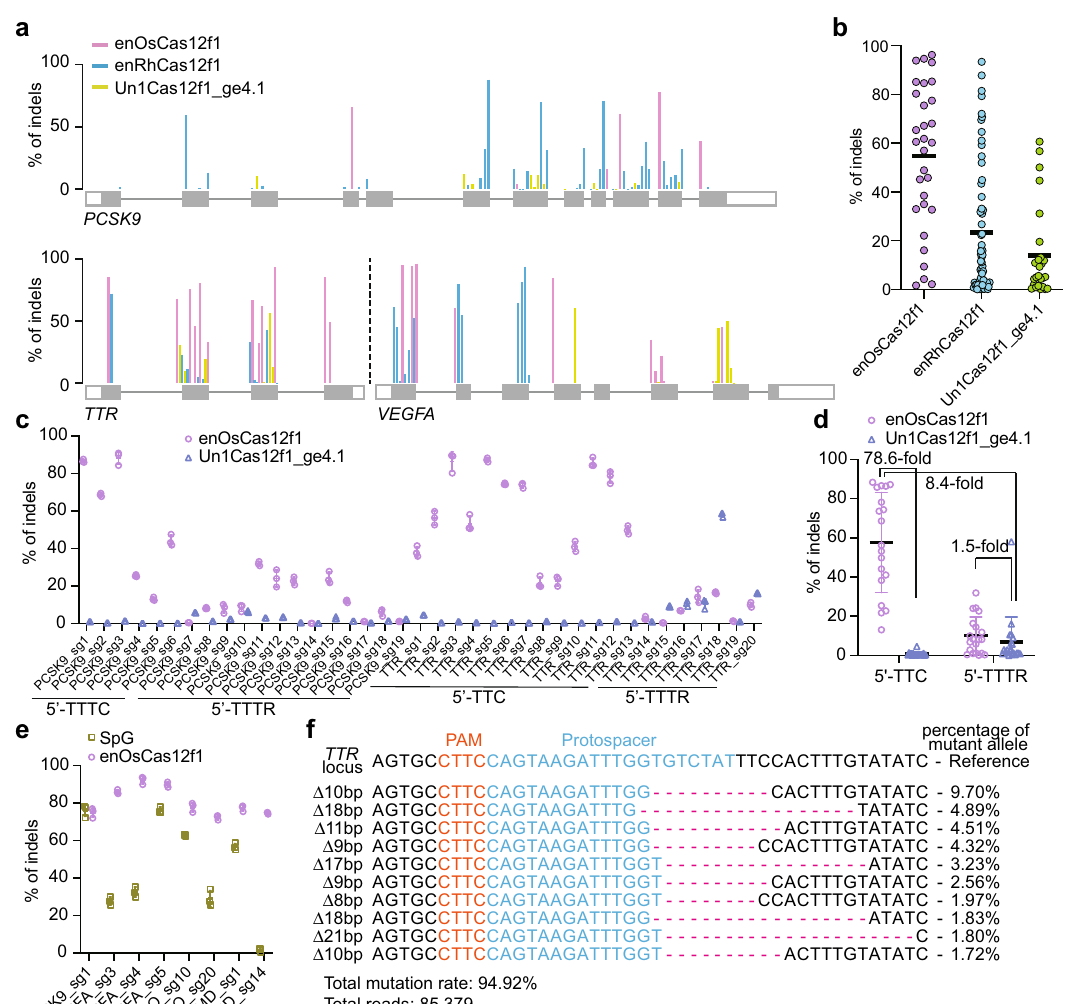
Fig. 4 |Comprehensivevalidationofgenomicediting ef fi ciencyofenOsCas12f1 andenRhCas12f1inhumancells.a Distributionofallexon-locatedtargetsitesthat are accessible for enOsCas12f1 (5 ’ -NTTC PAM), enRhCas12f1 (5 ’ -CCCA PAM), and Un1Cas12f1_ge4.1 (5 ’ -TTTR PAM), and the indel frequencies are indicated by mean values of three replicates, determined by NGS. The exon (gray solid squares) is connected by intron (lines), and UTRs are shown as hollow boxes. b Indel fre- quencies of enOsCas12f1, enRhCas12f1 and Un1Cas12f1_ge4.1 at endogenous geno- mic loci. Each dot represents single target site, value means average of three replicates. Bars represent means. c Comparison of editing ef fi ciencies of